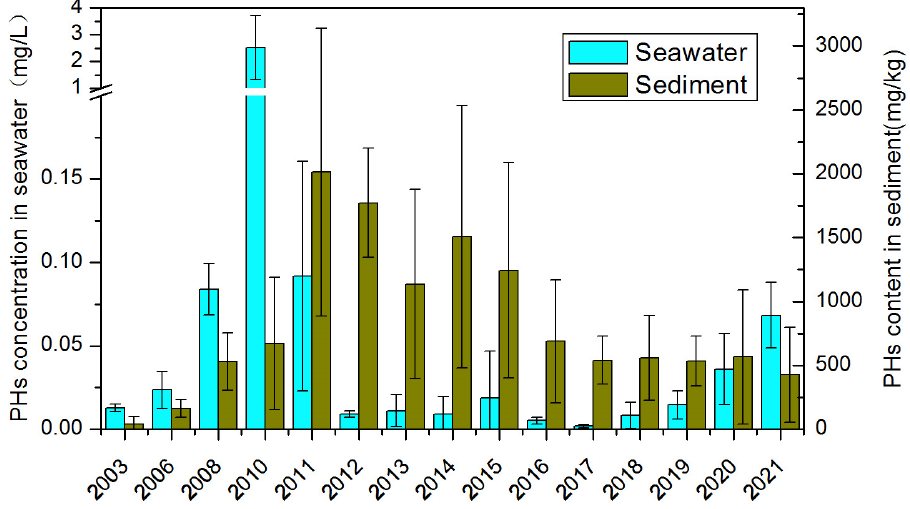
Figure 8. Petroleum hydrocarbon concentrations in seawater (cyan bar) and petroleum hydrocarbon content of sediment (dark yellow bar) in Dalian coastal sea from 2003 to 2021.